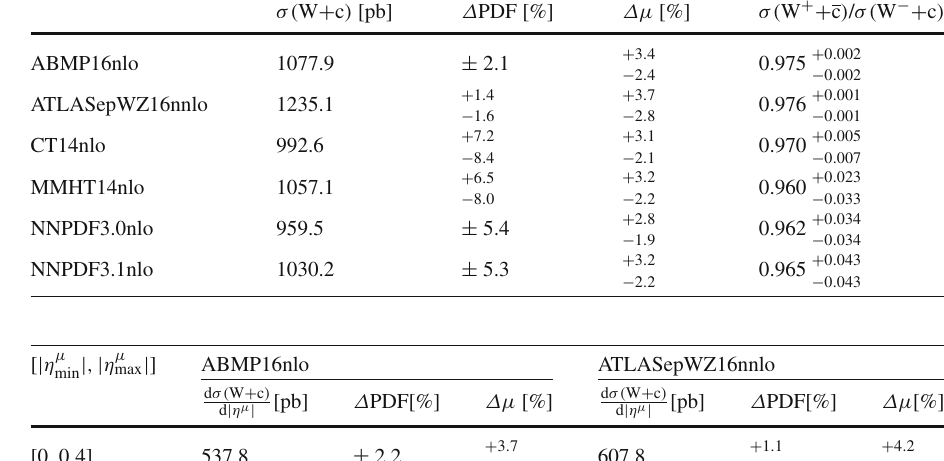
for d σ( W + c )/ d | η μ | calculated with mcfm at NLO for different PDF sets. The relative uncertainties due to PDF